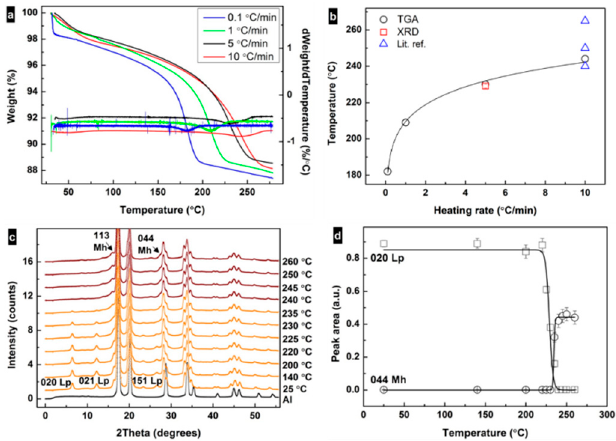
Figure 2. ( a ) Thermal gravimetric analysis (TGA) curves and their derivatives for the samples heated at 0.1, 1, 5 and 10 °C/min rates. ( b ) Correlation between heating rate and transformation temperature of lepidocrocite as obtained from TGA and X-ray diffraction (XRD) data and from literature [26,27,32]. ( c ) Lepidocrocite (orange) to maghemite (red) transformation upon heating at 5 °C/min under air from in situ XRD patterns. Black curve represents Al from the specimen pan. ( d ) Change in integrated intensities of the 020 lepidocrocite and 440 maghemite diffraction peaks under heating. During heating, hydroxyl groups get enough energy to form a water vapor via condensation with the closest hydroxy group (H + + OH − ); the collapse of the interlayer distance can explain, e.g., the decrease in 020 Lp diffraction peak in the XRD pattern. The size and morphology of the